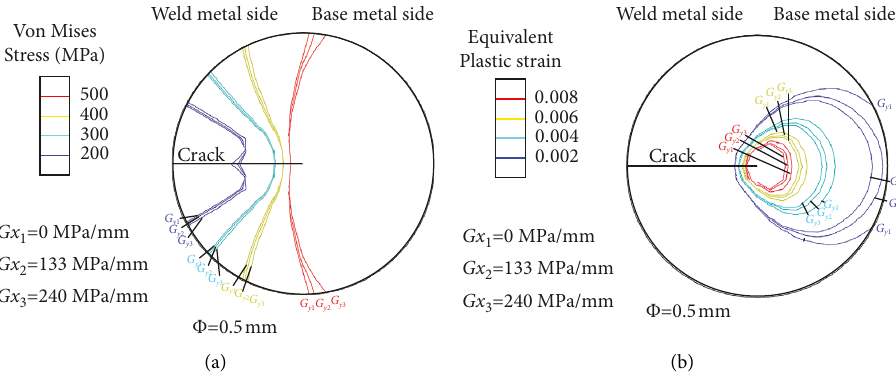
Figure 10: Contour of the USDFLD subroutine welded joint model whose yield strength changes in the x -direction. (a) Von Mises stress contour at crack tip. (b) Equivalent plastic strain contour at crack tip.